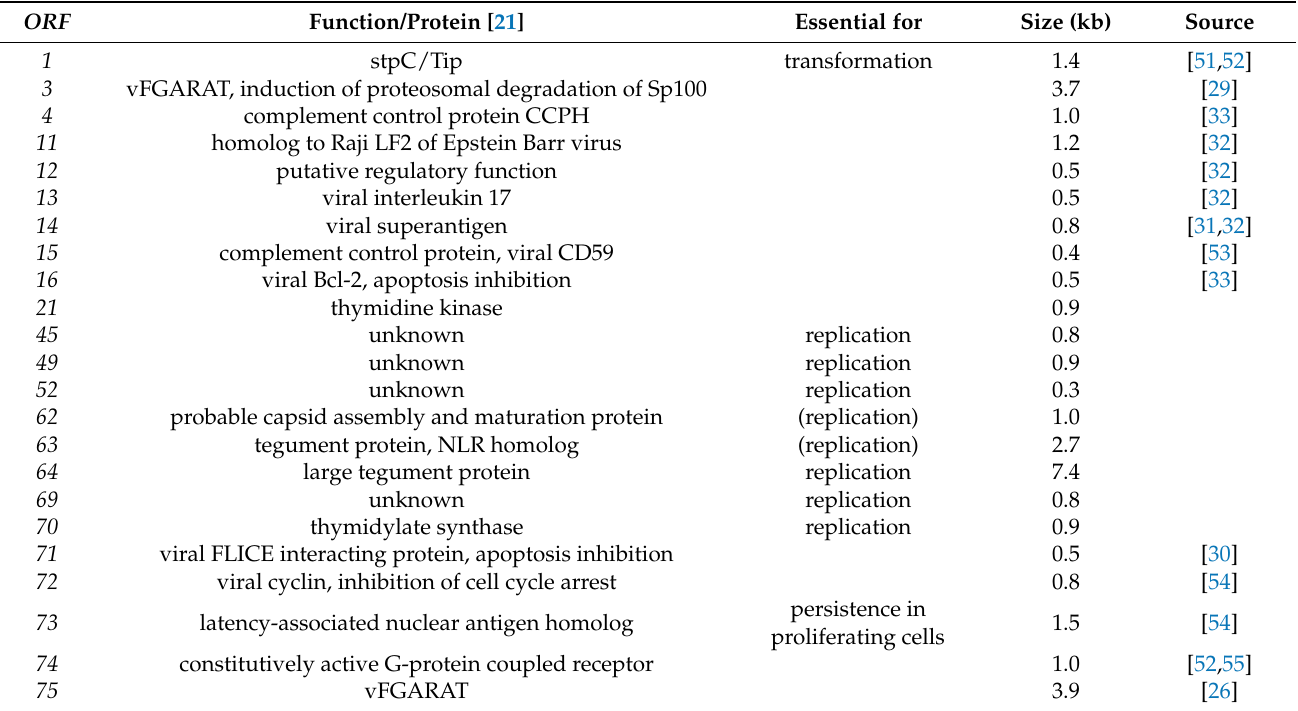
Table 2. Selected HVS C488 ORFs.